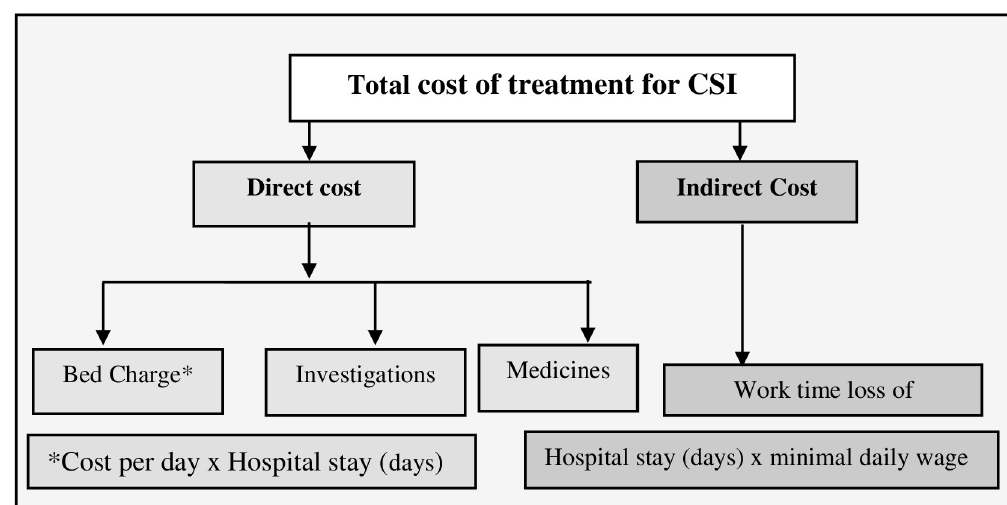
Fig 2. Components of treatment costs for clinical severe infection in infants aged 3–59